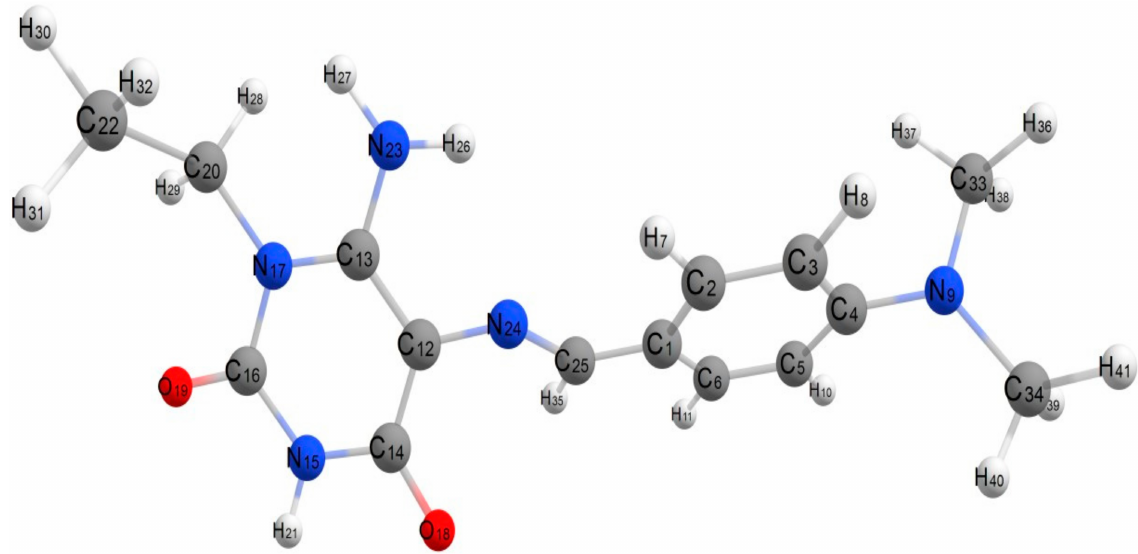
Figure 12. Optimized geometrical structure of compound ( 16 ), 6-amino-5-((4-(dimethylamino) benzylidene)amino)-1- ethylpyrimidine-2,4(1 H ,3 H )-dione by using DFT